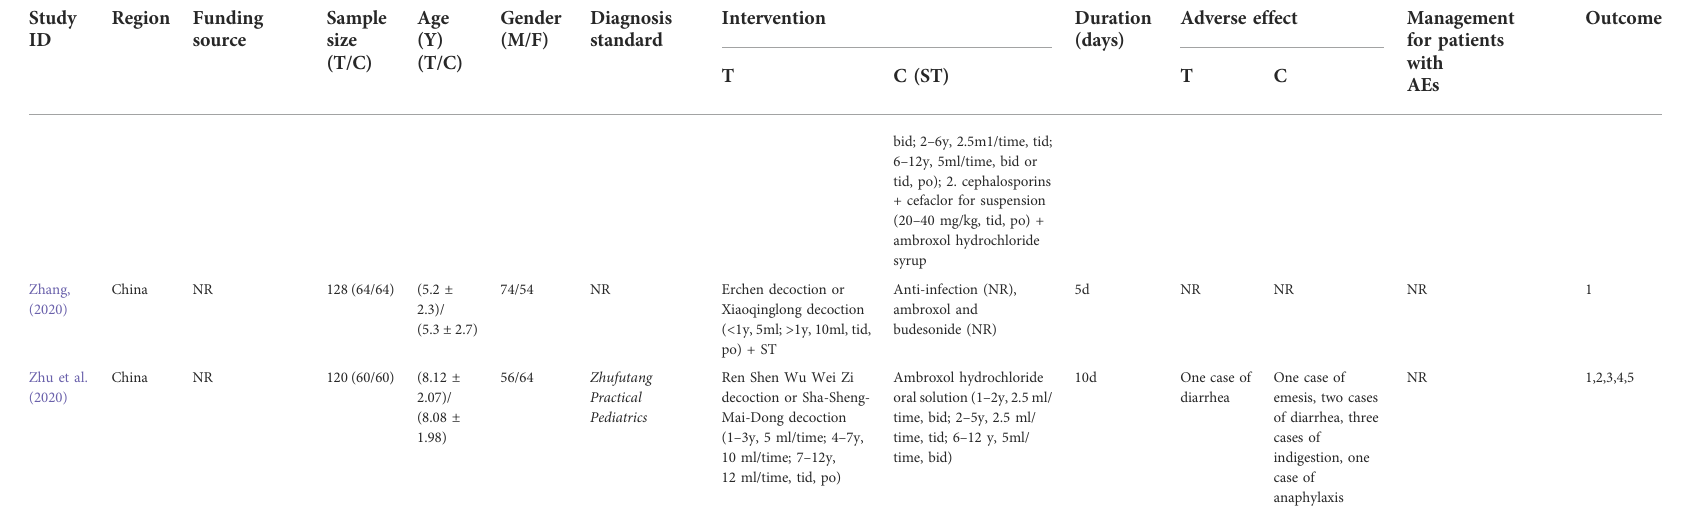
TABLE 1 ( Continued ) Baseline characteristics of the selected studies for